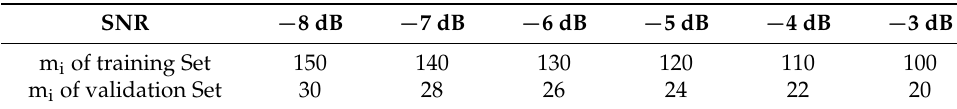
Table 1. Number of m i in the training set and validation